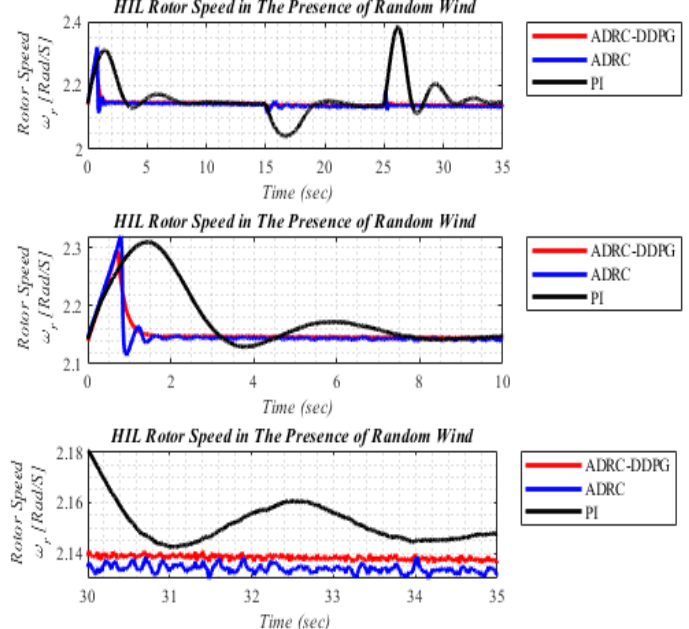
Figure 14. HIL output comparative results of ADRC-DDPG, ADRC and PI controllers according to scenario II.